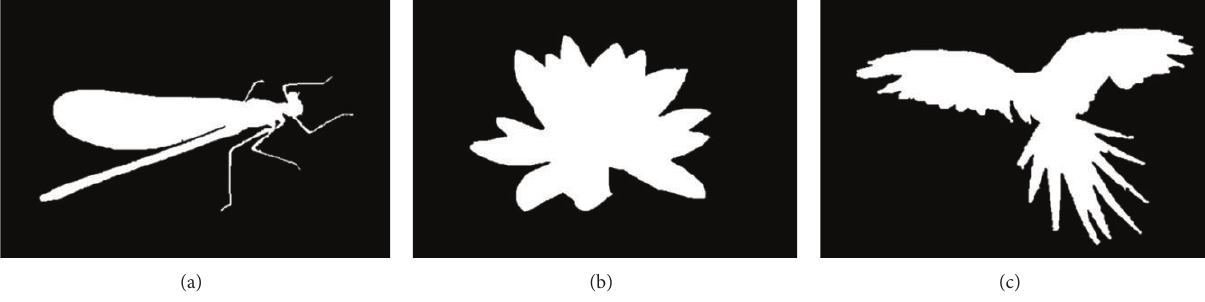
Figure 3: Samples of the manual binary ground truths generated.